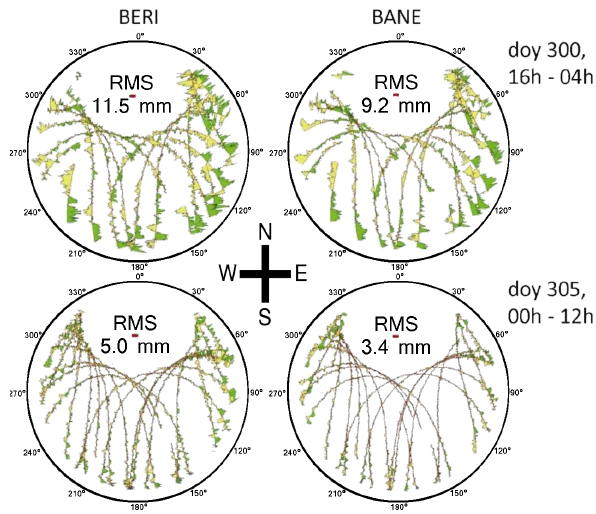
Figure 9: Skyplots of post-fit residuals for the two sites distant of 3 km: BANE (right column) and BERI 2 Fig. 9. Skyplots of post-fit residuals for the two sites distant of 3km: (left column), during high (upper line) and low (lower line) RMS conditions. Post-fit residuals are 3 BANE (right column) and BERI (left column), during high (up- evaluated at each measurement interval (every 30 sec), during 12 h sessions on days 300 (high RMS) and 4 per line) and low (lower line) RMS conditions. Post-fit residuals 305 (low RMS). 5 are evaluated at each measurement interval (every 30s), during 12h sessions on days 300 (high RMS) and 305 (low